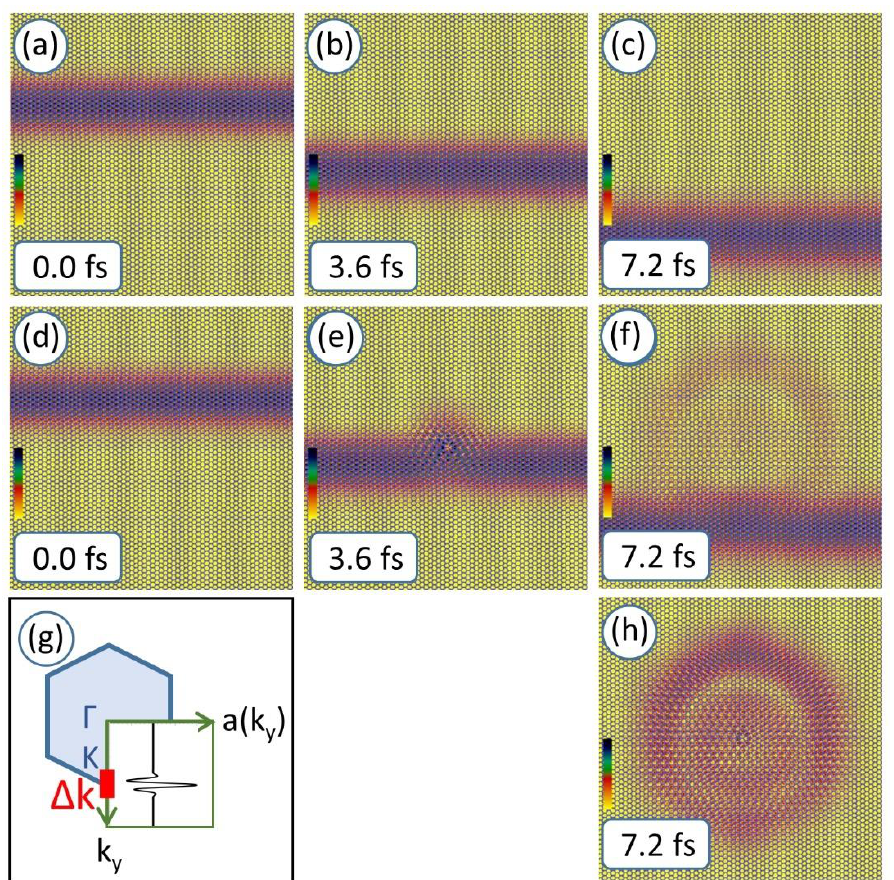
Figure 2. Time evolution of the probability density of a Bloch function wave packet in the graphene pseudopotential. ( a – c ) Without defect. ( d – f ) With defect. ( g ) Spectral distribution of the Bloch function wave packet in the Brillouin zone, only the real part of 𝑎(𝑘⃗⃗) is shown. The red bar shows the reciprocal space width Δ𝑘 . ( h ) Scattering pattern, absolute value of the difference of the WPs shown on ( c , f ). The size of the calculation window is 14.48 nm. (see Video S1 for the time development of the Bloch WP)